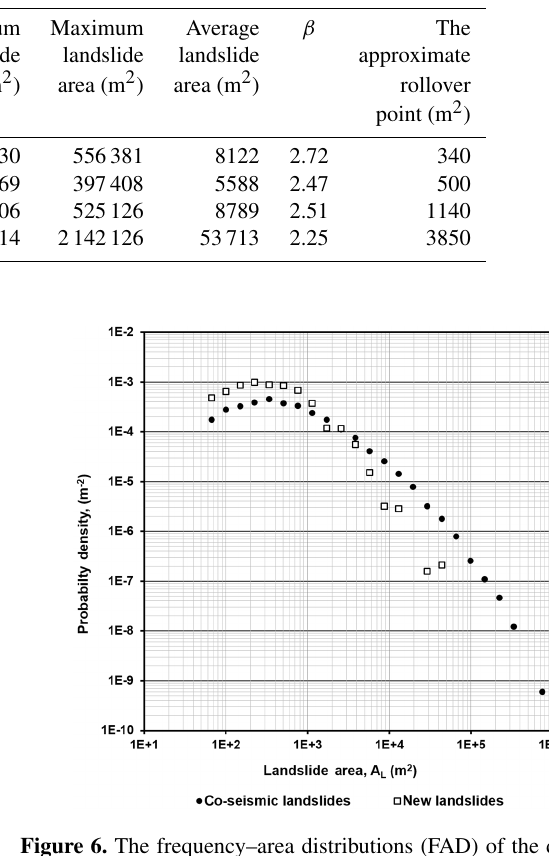
Figure 5. Comparing our inventory with the landslide initiation point inventory by Gorum et al. (2011) and the polygon-based in- ventory by Dai et al. (2011) for a small part of the area.